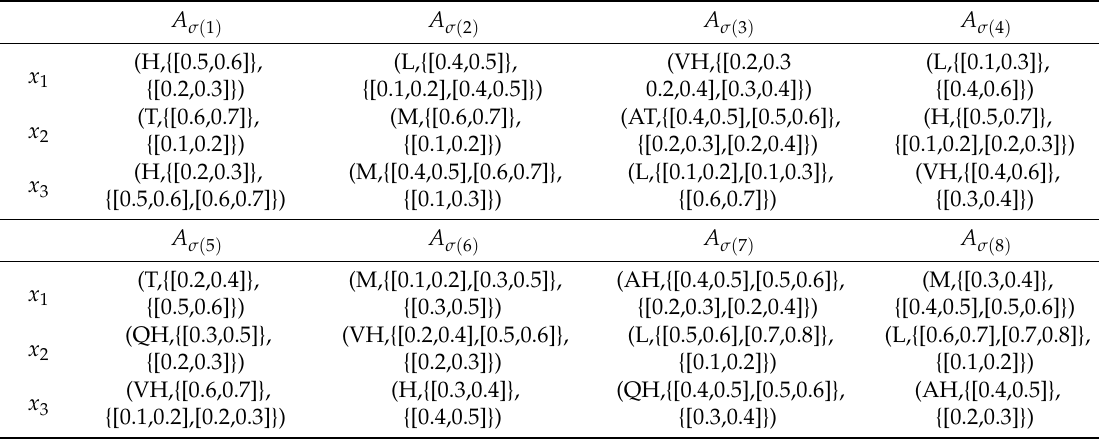
Table 5. The prioritized individual IVDHFUBL decision matrix R 1 .